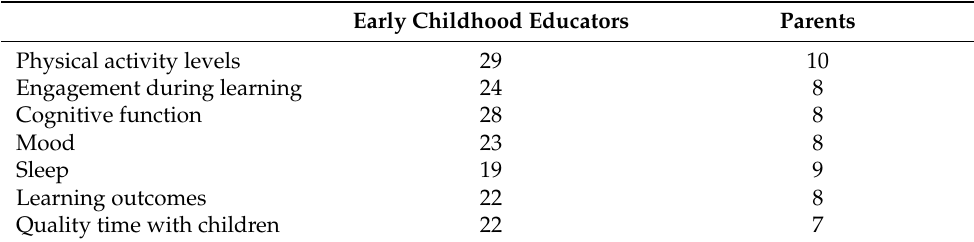
Table 5. Participant responses regarding potential